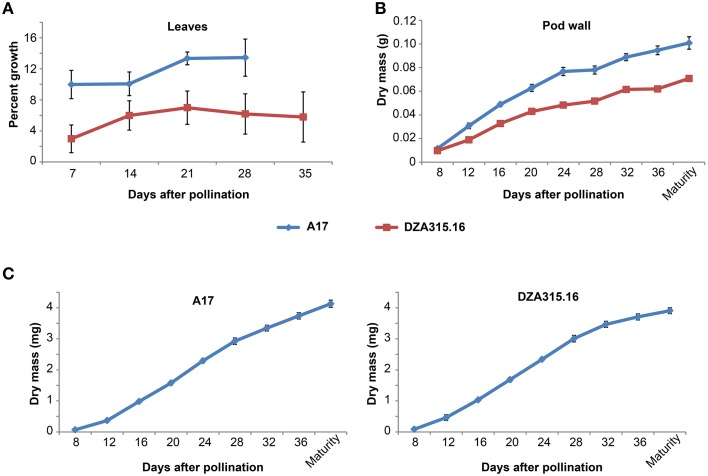
Vegetative and reproductive tissue growth dynamics. (A) Percent growth of leaflets for A17 (blue line) and DZA315.16 (red line) was calculated relative to the total leaflet area at pollination. The percent growth of leaflets from seven leaves for A17 and six leaves for DZA315.16 was averaged for each time. (B,C) Dry masses of pod walls (B) and seeds (C) were averaged from two replicated experiments. Tissues were harvested at 4-day intervals during pod development beginning at 8 days after pollination and continuing through pod maturity for ecotype A17 (blue line) and DZA315.16 (red line). For all panels, error bars display SEM.